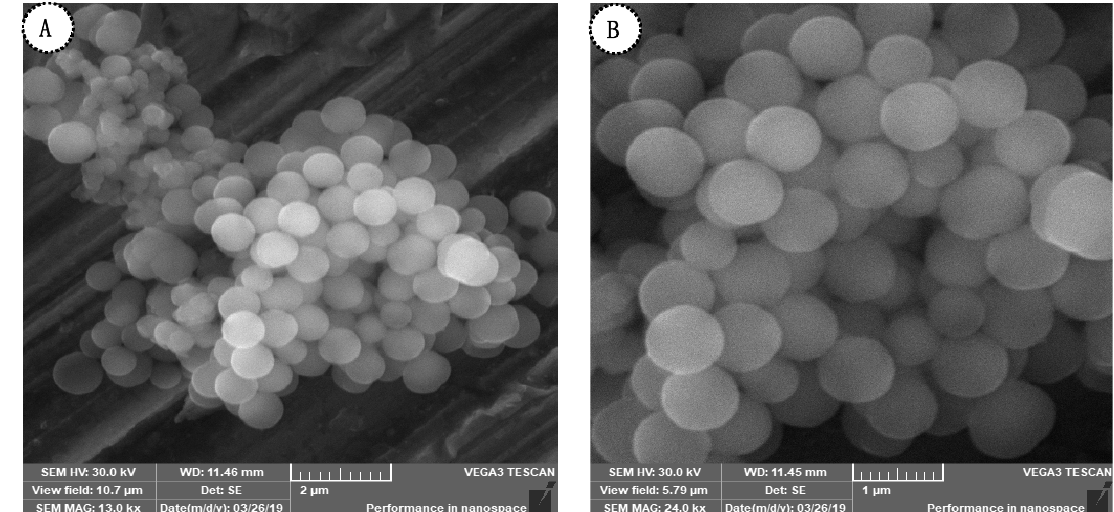
Figure 2. SEM of SiO 2 -NPs at different magnifications ( A ) 13 kx, ( B ) 24 kx.